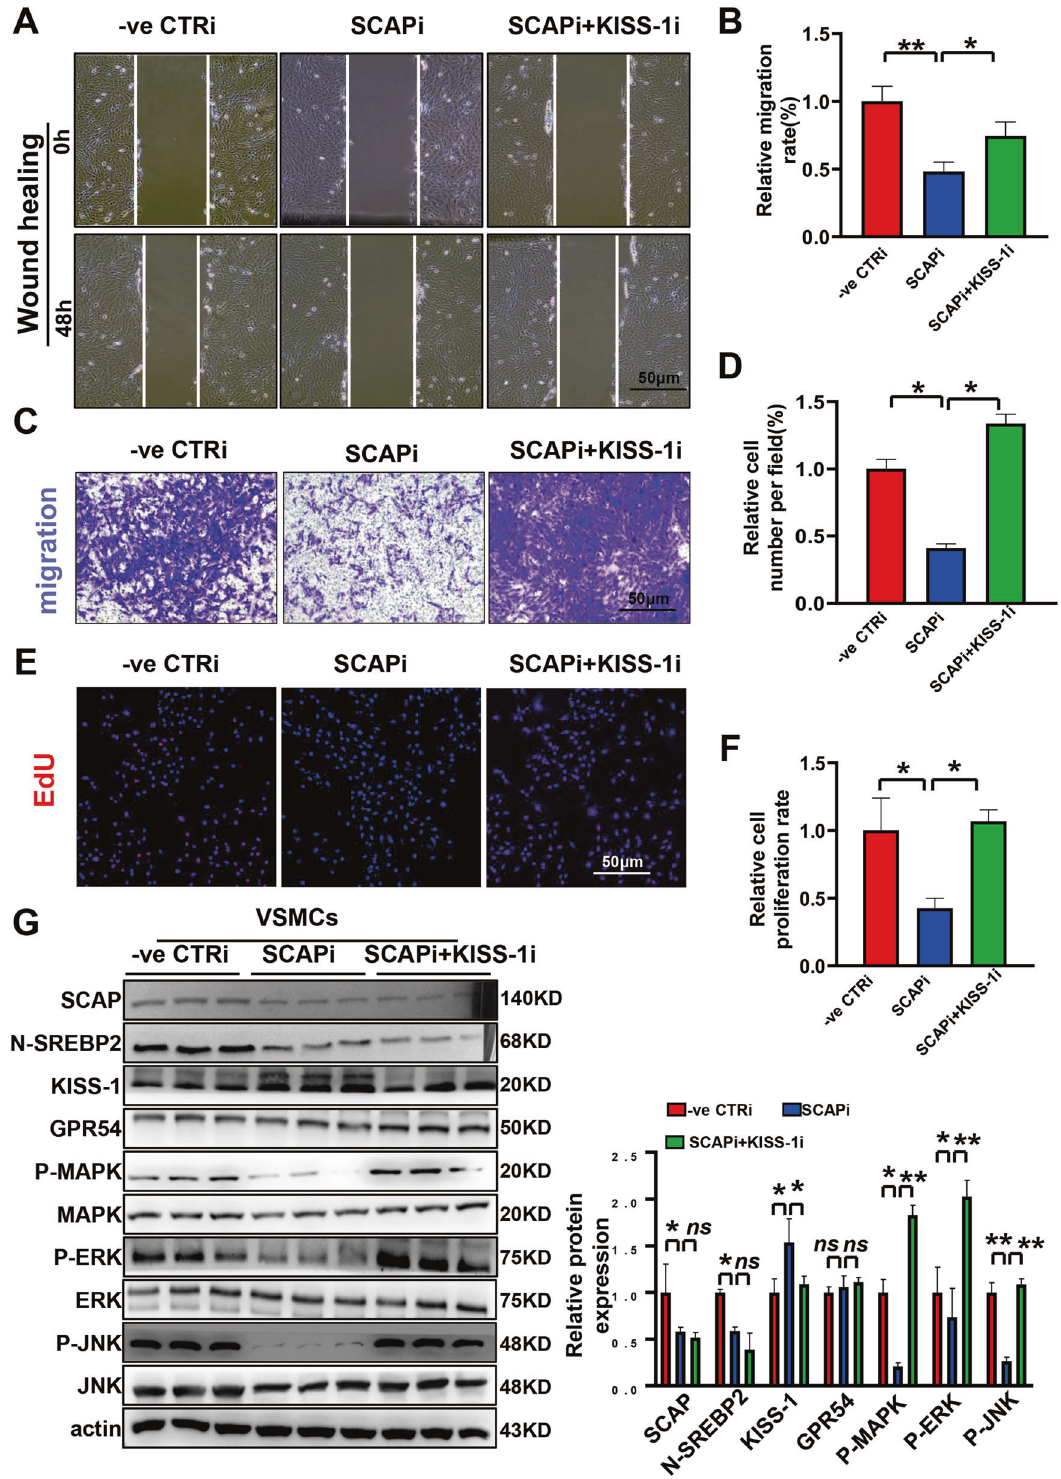
Fig. 5 Knockdown of KISS-1 expression rescues SCAP-ablated VSMCs from loss of proliferation and migration abilities in vitro. A Representative images of wound-healing migration assays in VSMCs treated with CTRi, SCAPi, SCAPi and KISS-1i for 0 h and 48 h. B Statistical analysis of the relative VSMC migration rates in ( A ). C Representative images of the Transwell migration assay in VSMCs treated with CTRi, SCAPi, SCAPi and KISS-1i. D Statistical analysis of the relative cell numbers per fi eld (%) in ( C ). E Representative images of the EdU assay in VSMCs treated with CTRi, SCAPi, SCAPi and KISS-1i. F Statistical analysis of the relative cell proliferation rate in ( E ). G Immunoblot analysis and quanti fi cation of SCAP, N-SREBP2, KISS-1, GPR54, P-MAPK, MAPK, P-ERK, ERK, P-JNK and JNK protein expression in VSMCs treated with CTRi, SCAPi, SCAPi and KISS-1i. All experiments were repeated at least 3 times. Data are presented as the mean ± SD. * P < 0.05, ** P < 0.01, *** P < 0.001. P values were calculated by Student ’ s t test.